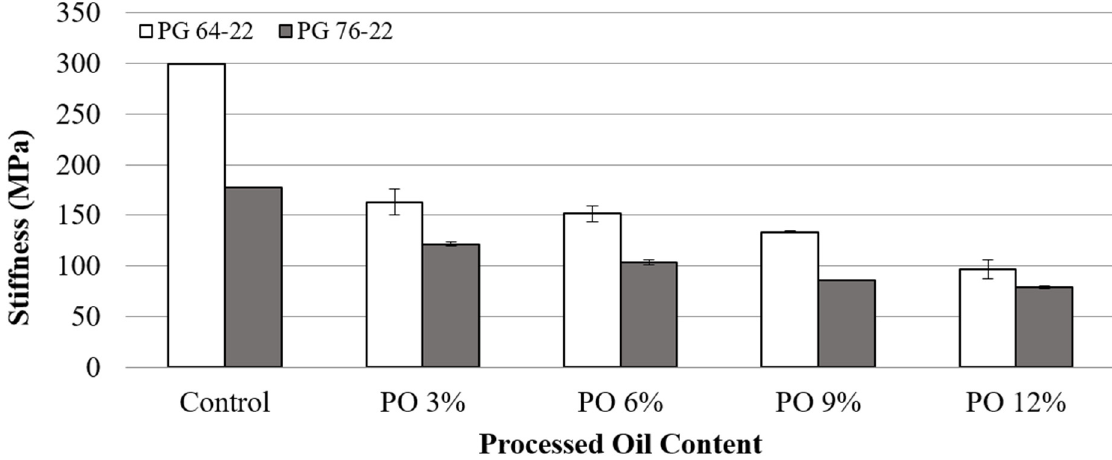
Figure 8. Stiffness of asphalt binder with processed oil at − 12 °C.